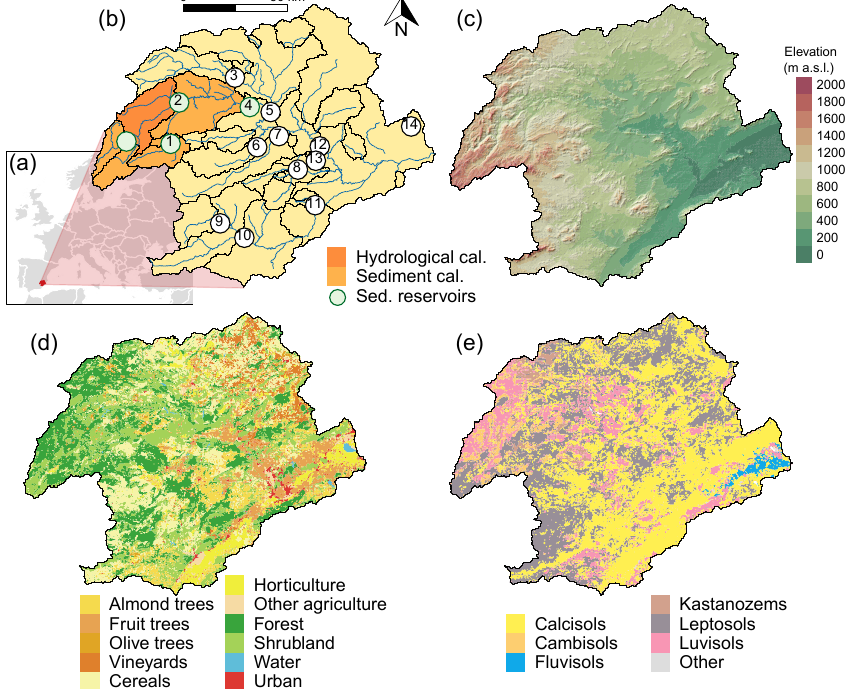
Figure 1. Location and characteristics of the Segura River catchment: (a) location of the catchment within Europe, (b) location of the subcatchments (yellow), the hydrological calibration area (dark orange), the soil erosion calibration area (light orange), the channels (blue), the reservoirs (numbers 1–14), and the calibration reservoirs (green dots), (c) digital elevation model (Farr et al., 2007), (d) land-use map (MAPAMA, 2010), and (e) soil classification map (Hengl et al., 2017).